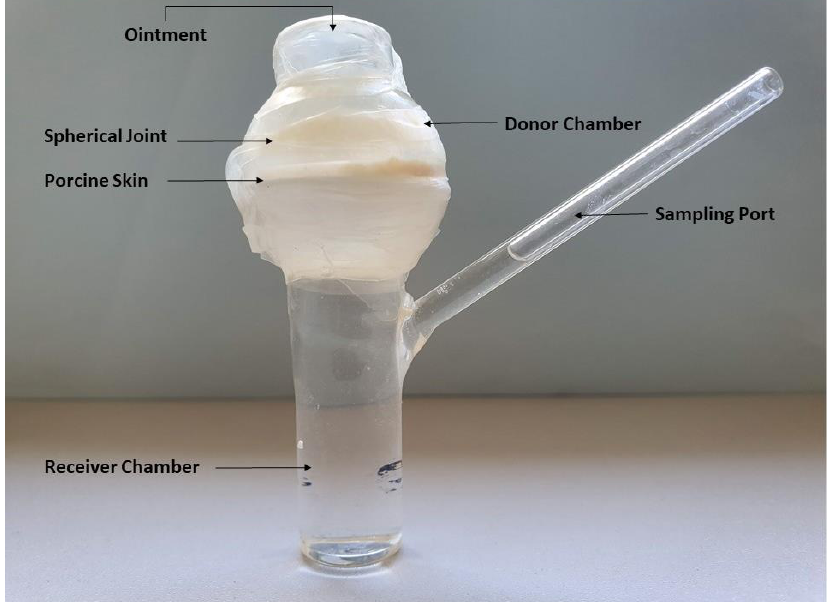
Figure 1. The scheme of vertical Franz cell with a spherical joint to ACTH penetration study through porcine ear skin in simulated in vivo conditions.